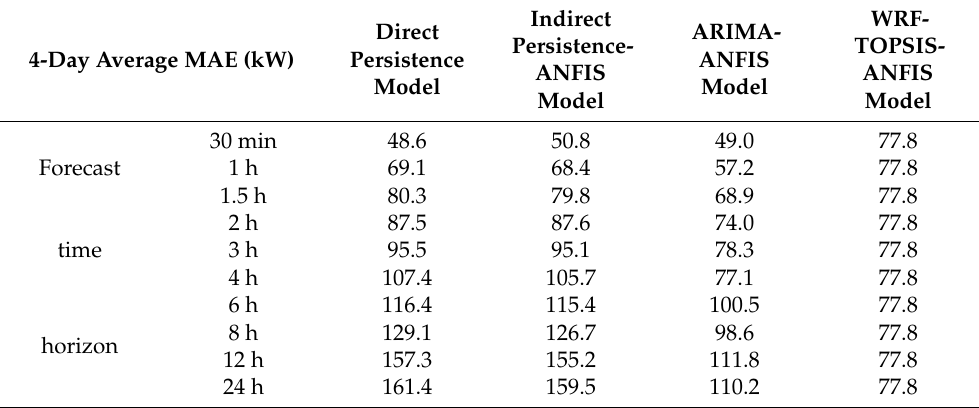
Table 14. Four-day average mean absolute error for the wind power forecasting using the direct persistence, indirect persistence-ANFIS, ARIMA-ANFIS, and WRF-TOPSIS-ANFIS models applied to the 4-day test dataset.